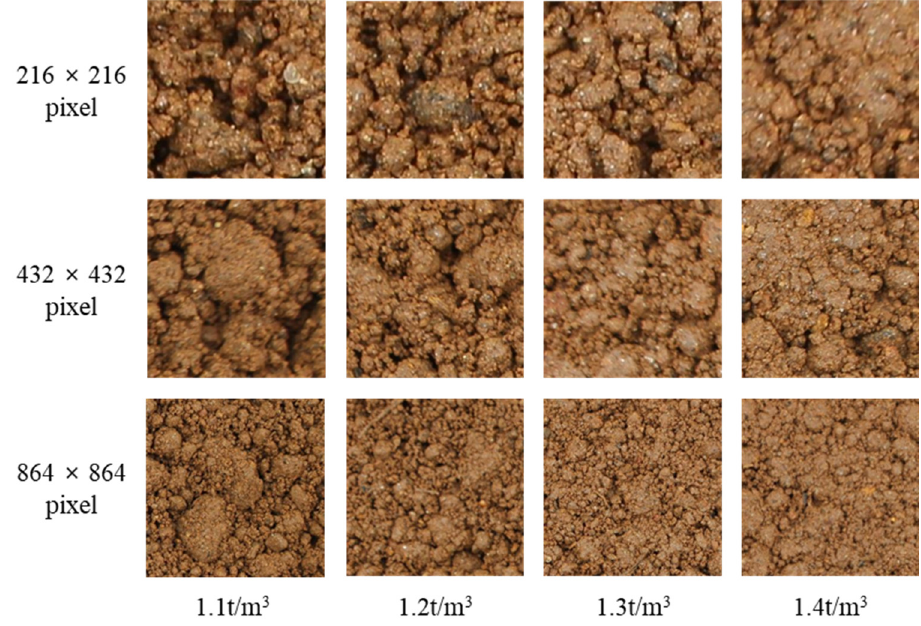
Figure 6. Sample segmented soil surface images under different soil dry density conditions. Each image is a cropped image with 3 different sizes from the original soil surface image with resolution of 5184 × 3456 pixels. Soil texture is loam.